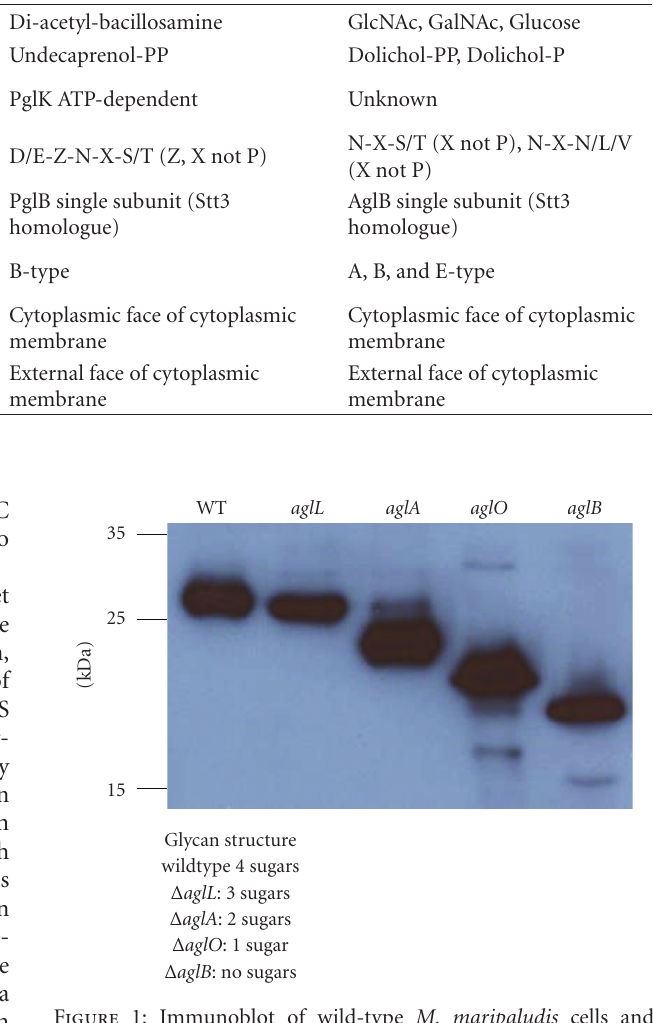
Figure 1: Immunoblot of wild-type M. maripaludis cells and mutants carrying deletions in various agl genes. Blots were devel- oped with anti-flagellin antisera. Blot shows almost quantitative transfer of truncated glycans